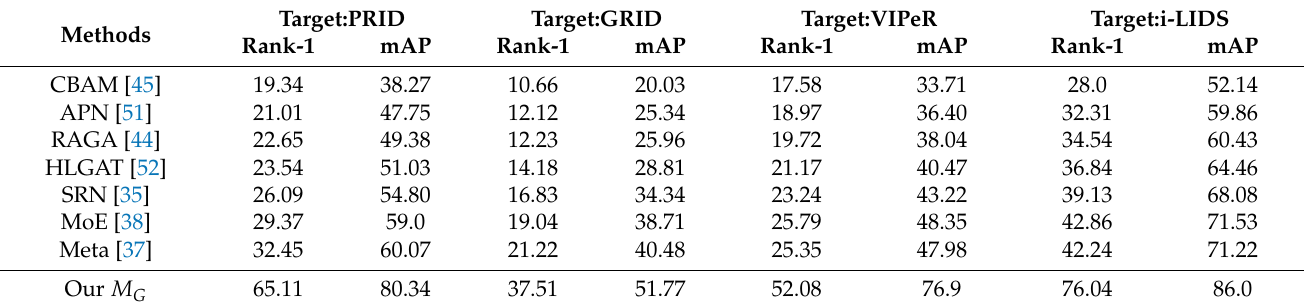
Table 6. Results on Challenging Open-World